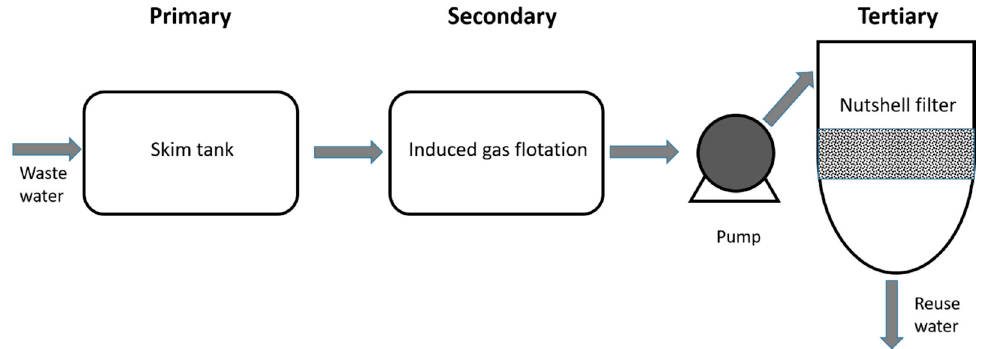
Figure 4. Nutshell filter arrangement for an onshore produce-water treatment plant [92].